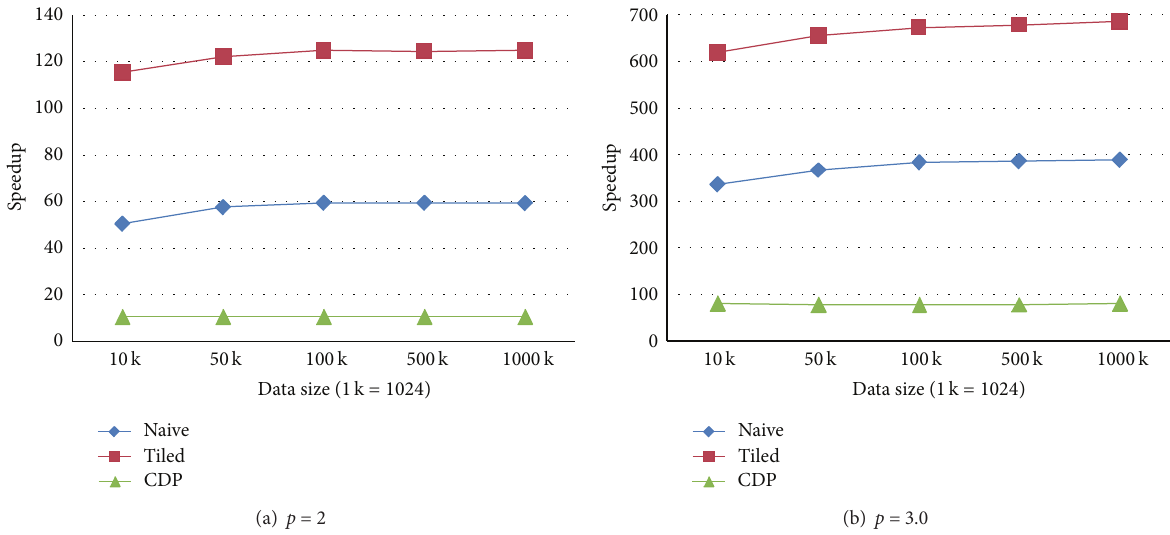
Figure 5: Speedups in the test case when the number of data points is fixed and the number of prediction points differs. (a) The form in which the power parameter is set to 2. (b) The form in which the power parameter is set to 3.0.